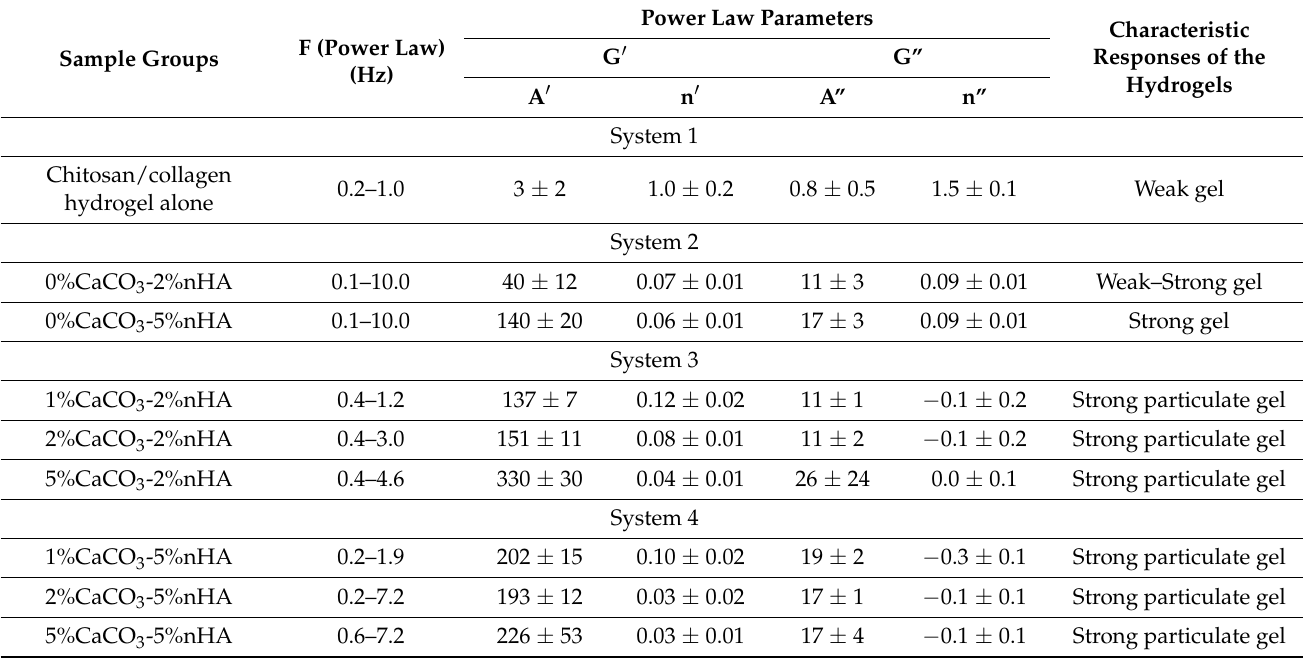
Table 2. Rheological parameters of the power law model for the frequency sweep test at 1% strain and types of